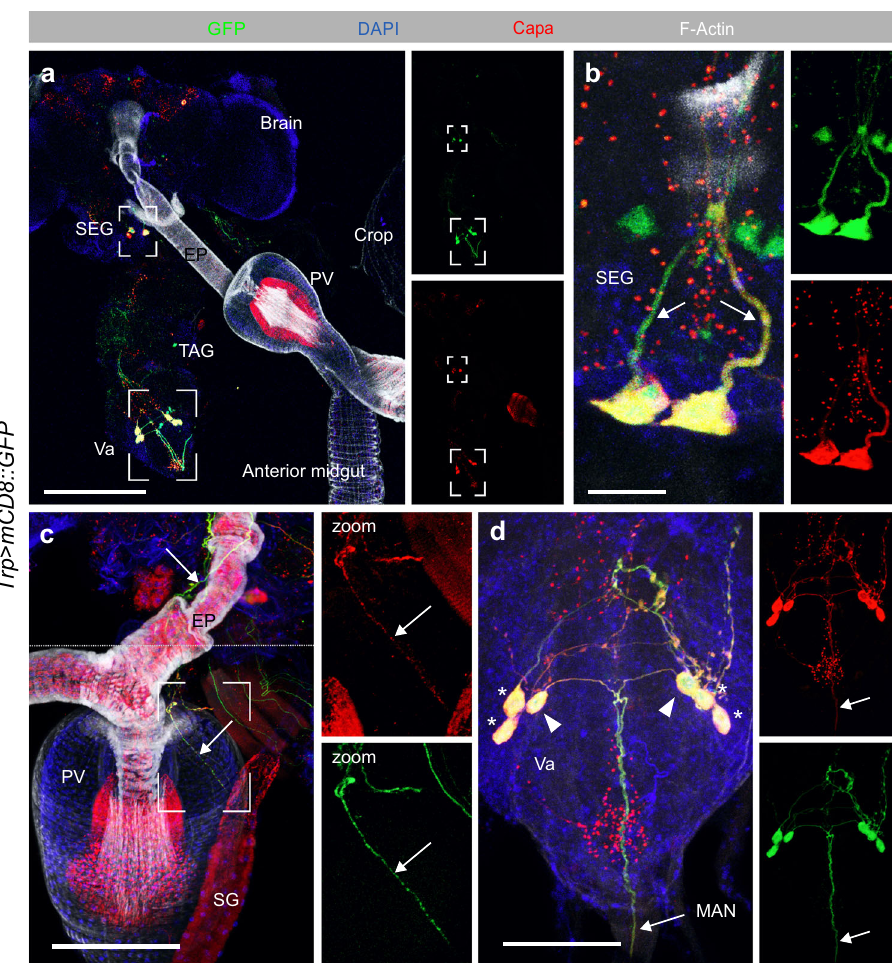
Fig. 3 Neuroanatomy of Capa-producing neurons. a – d The CNS and associated tissues showing Trp > mCD8::GFP (green) counterstained with an anti- Capa antibody (red), F-Actin (white) and DAPI (blue) in maximum projected z-stack confocal images. The experiment was repeated multiple times with the same results. a GFP expression and anti-Capa immunoreactivity co-localize in four pairs of Capa + neurons; one pair in the subesophageal ganglion (SEG) and three pairs in the thoracicoabdominal ganglion (TAG). Scale bar, 200 μ m. b The SEG neurons extend dorsally. Scale bar, 20 μ m. c The SEG neurons also extend along the esophagus (EP) to innervate the proventriculus (PV). Scale bar, 50 μ m. Image was acquired using “ Tile scan ” in the ZEN software (Zeiss, Oberkochen, DE) with the boundary between tiles marked by dashed line. d The two anterior pairs (*) of ventroabdominal (Va) neurons send axons to the dorsal neural sheath, while the posterior pair (triangles) projects into the median abdominal nerve (MAN) and form neurohemal release sites. Scale bar, 50 μ